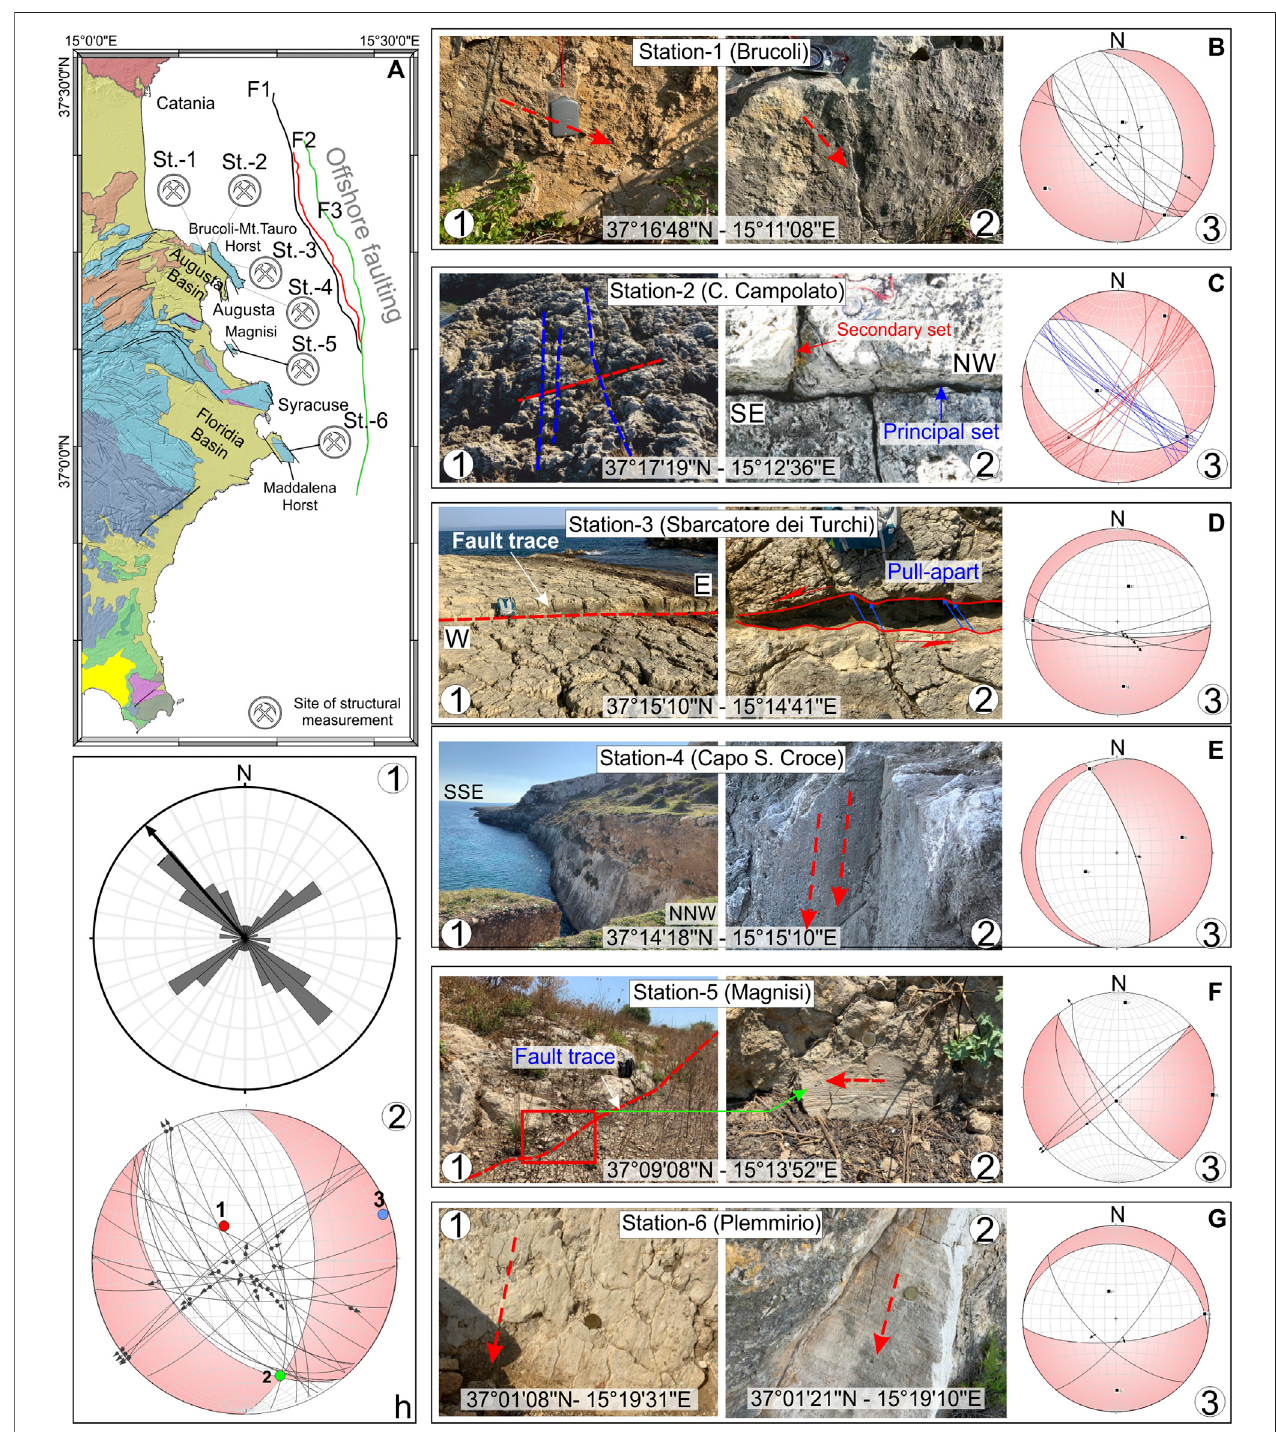
FIGURE 6 | (A) Location of the sites of structural measurements performed along the footwall block of the Malta Escarpment (SE Sicily coastal domain, see Figure1B forthegeologyon-land)andcollectedfaultplanesandkinematicindicators (B – G) .Diagramsontherightpanels(Schmidtlowerhemisphere)showfaultsplane attitude andmovementontherespectivehangingwalls(blackarrows)andcalculatedpseudofocalmechanisms.h-1)Rosediagramofthewholemesostructuraldataset showing the faults having a dominant strike in the range N130 – 140E. h-2) Stress fi eld derived from slip-data inversion highlighting the area as deformed under a slightly transtensional tectonic regime characterized by a ∼ 70 ° plunging, NNW – SSE trending σ max.